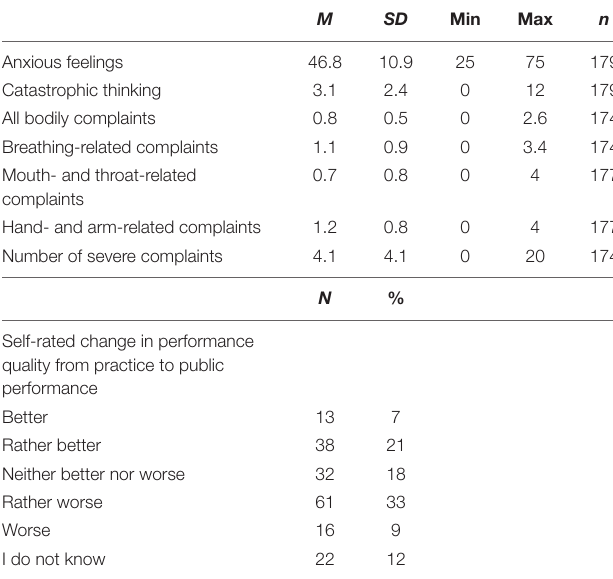
TABLE 1 | Descriptive statistics for anxious feelings, catastrophic thinking, bodily complaints, and self-rated change in performance quality from practice to public